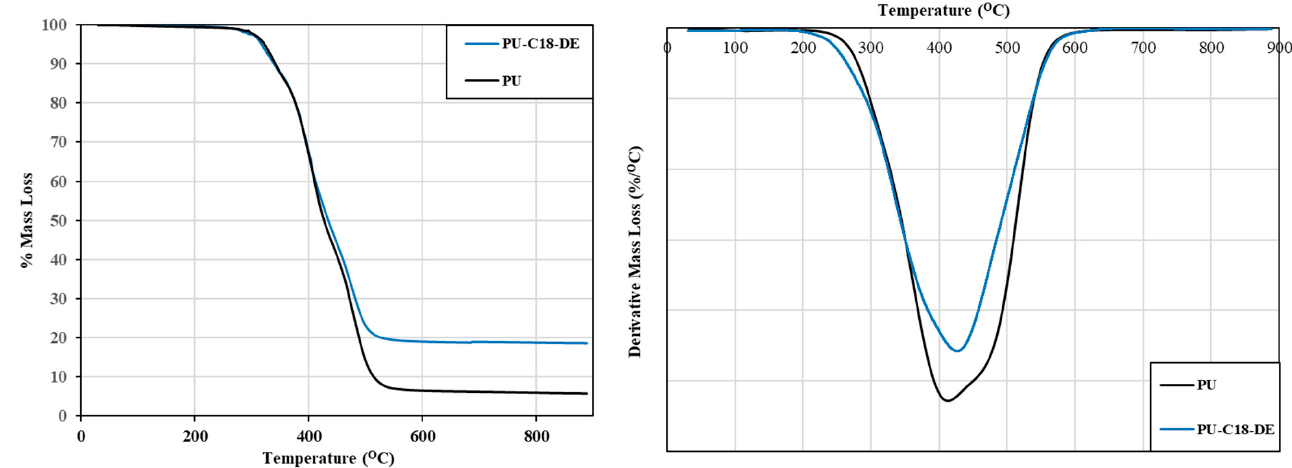
Figure 3. TGA ( left image) and the corresponding DTA curve ( right image) of PU and PU-C18-DE.